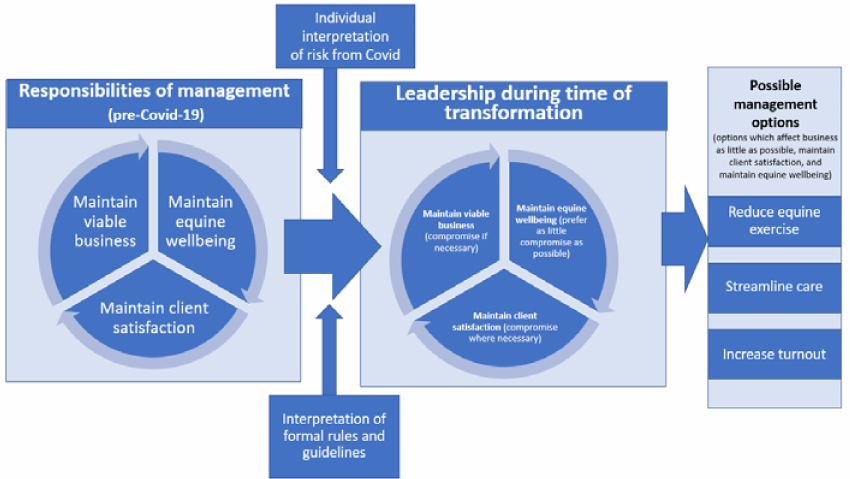
Figure 1. Conceptual diagram of livery yard manager/owner’s move from pre-COVID-19 pandemic responsibilities towards decision making and change due to the pressures of the